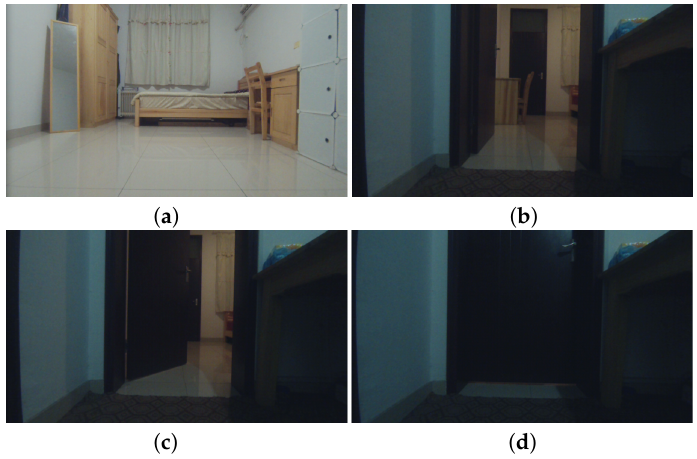
Figure 6. Sample images of the dataset for controller model, ( a ) without the door; ( b ) with fully-open door; ( c ) with the semi-open door; ( d ) with the fully-closed